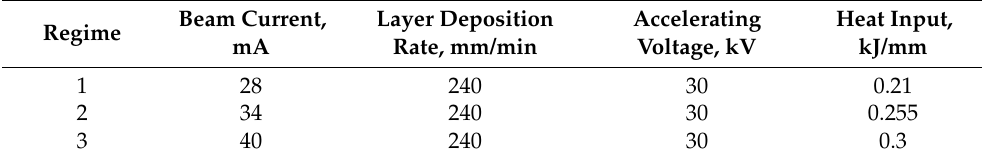
Table 1. EBAM process parameters.